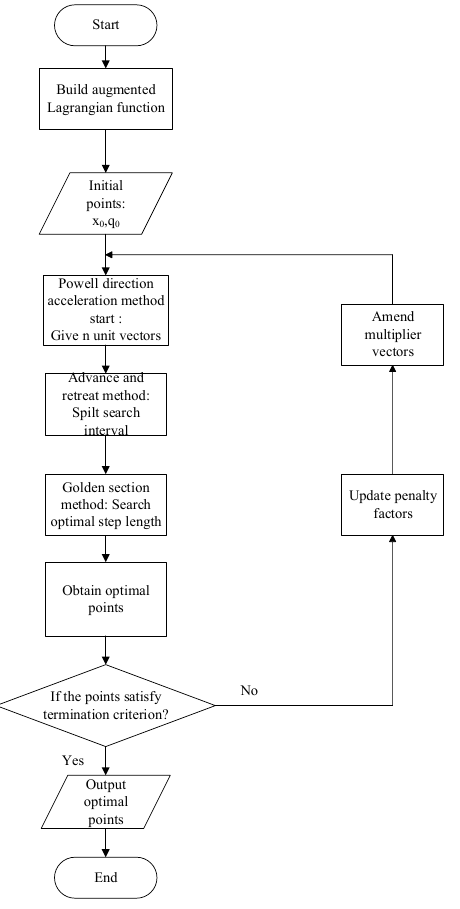
Figure 2. The flowchart of the iterative